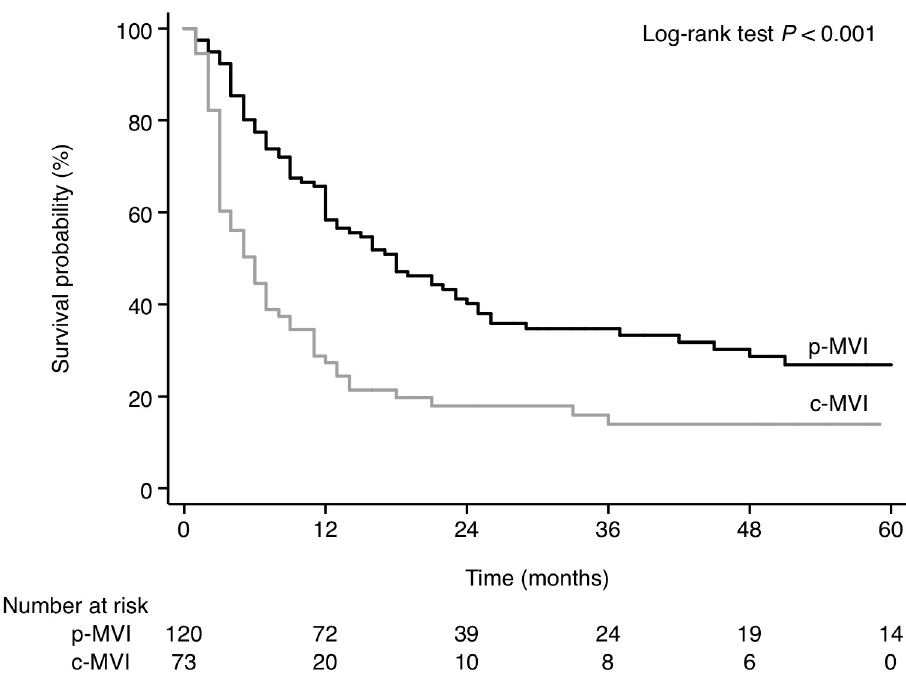
Fig 3. Survival of patients according to the type of MVI extension (black line, p-MVI; gray line, c-MVI). p-MVI was defined as tumor invasion of the intrahepatic branches of the portal vein or hepatic veins. c-MVI was defined as tumor invasion of the main portal trunk or inferior vena